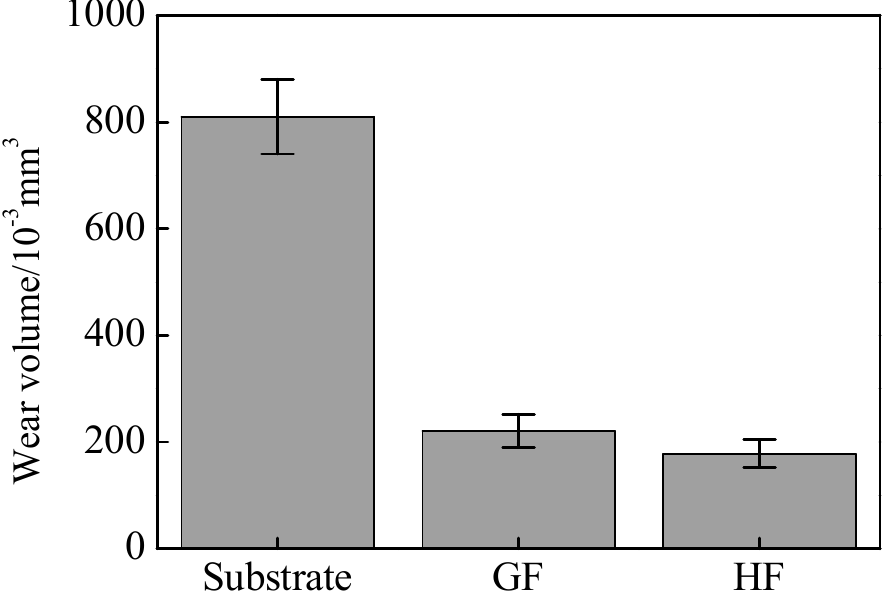
Figure 13. Volume loss of substrate, GF and HF coating.